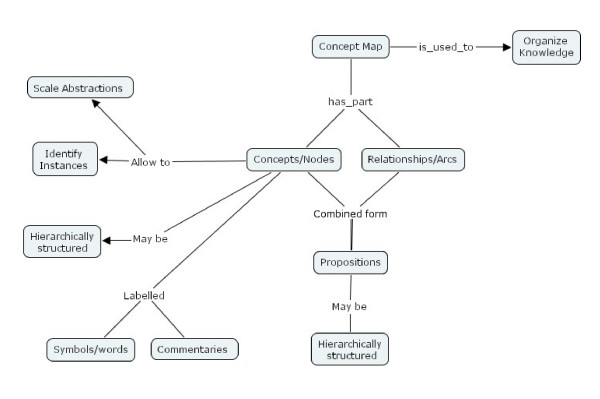
View of a concept map. Adapted with permission from [10].